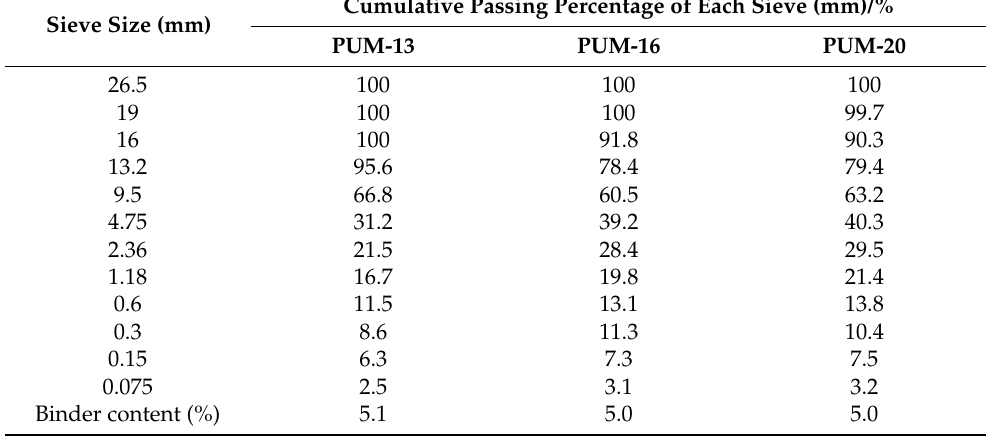
Table 3. Material composition design results of PU